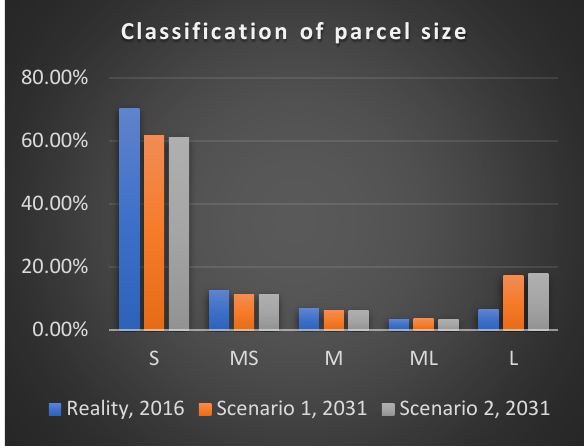
Figure 4 . Classification of parcel size (by